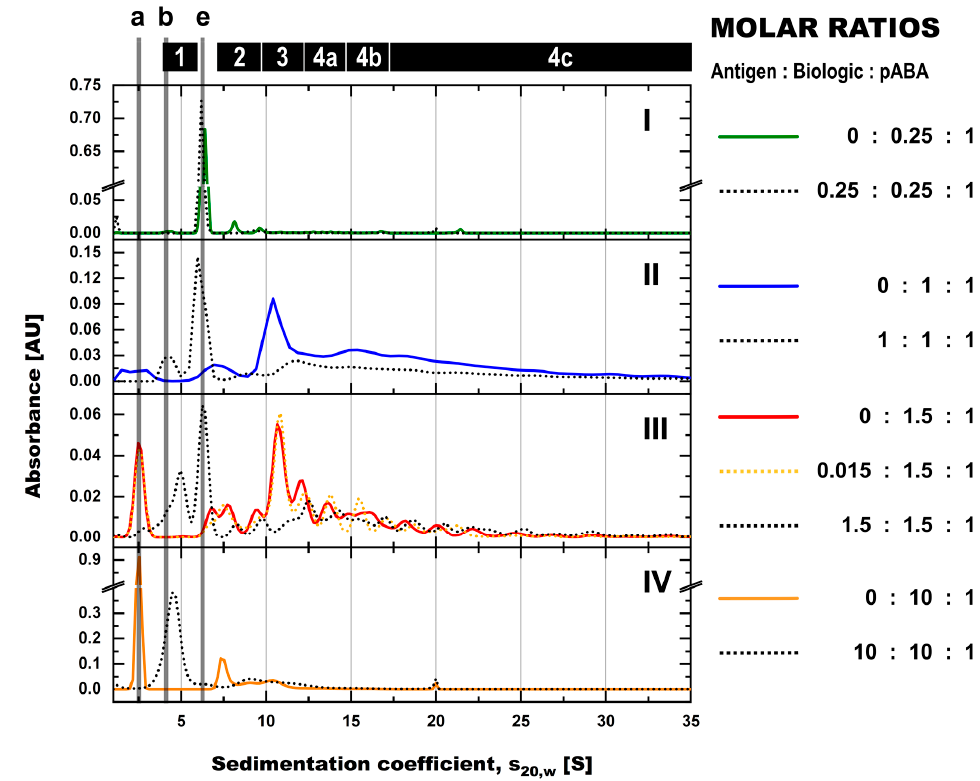
Figure 4. SV-AUC assessment of formed immune complexes in PBS in presence and absence of antigen and the impact of molar ratios between biologic and pABA. SV-AUC profiles are shown for biologic:pABA compositions of the following molar ratios in absence (full line) and in presence of antigen (dotted lines)—0.25:1 on panel ( I ), 1:1 on panel ( II ), 1.5:1 on panel ( III ), and 10:1 on panel ( IV ). Presence of antigen in equimolar ratio to biologic and according to figure legend for the 1.5:1 biologic:pABA ratio. Marker: (a) free biologic, (b) free antigen, (e) free pABA, (1) antigen:biologic complexes, (2) immune complexes with a single ABA incorporated, (3) immune complexes with two incorporated ABAs, (4a) immune complexes with three incorporated ABAs, (4b) immune